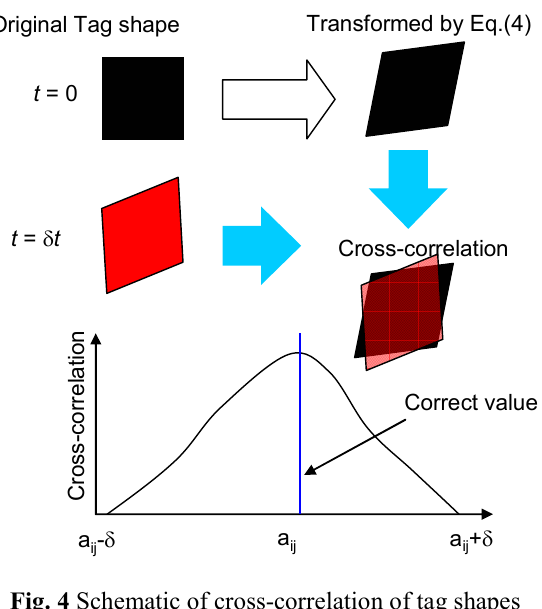
Fig. 4 Schematic of cross-correlation of tag shapes